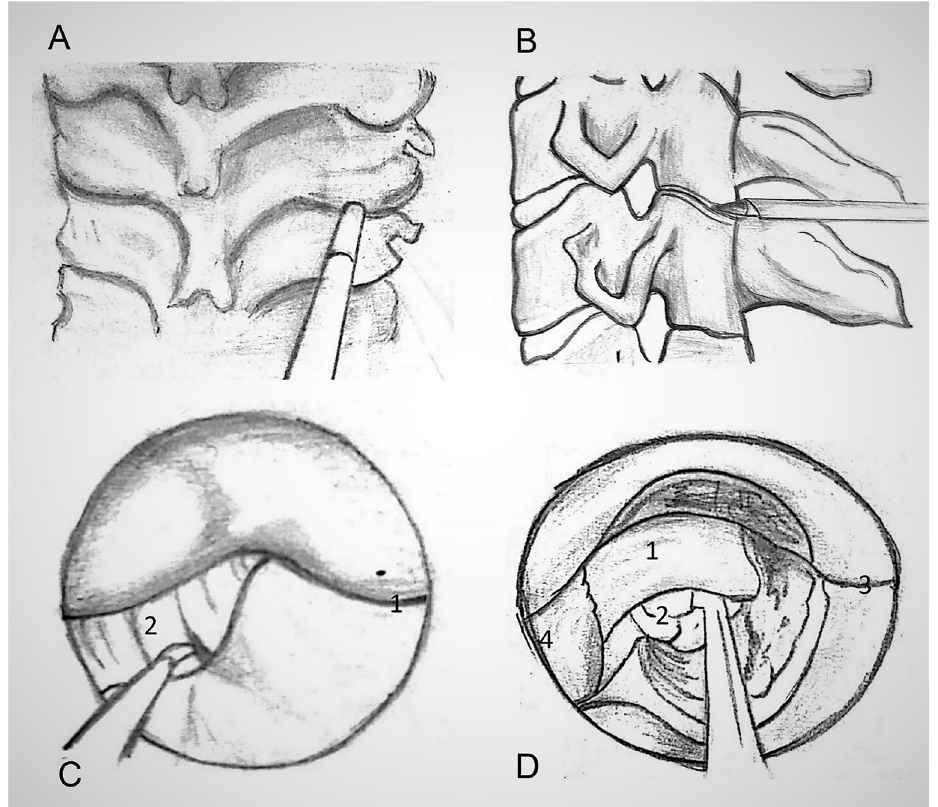
Figure 6. Surgical diagrams for Endoscopic Posterior Cervical Foraminotomy and Discectomy techniques: A and B localize of working cannula. C The facet joint is identified by removing the overlying soft tissue: (1) Facet joint (2) yellow ligament. D Final operative view: (1) nerve root (2) disc herniation (3) Facet joint (4) yellow